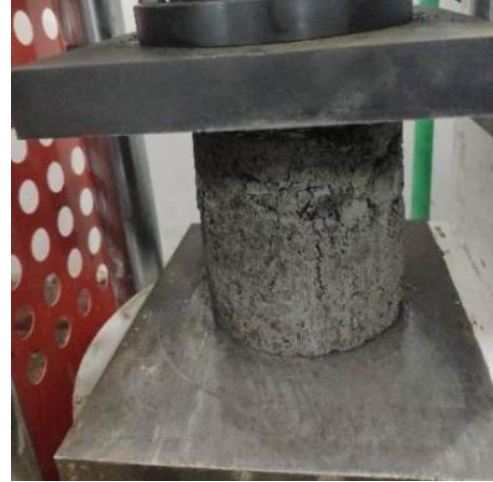
Figure 2. Axial compressive-strength